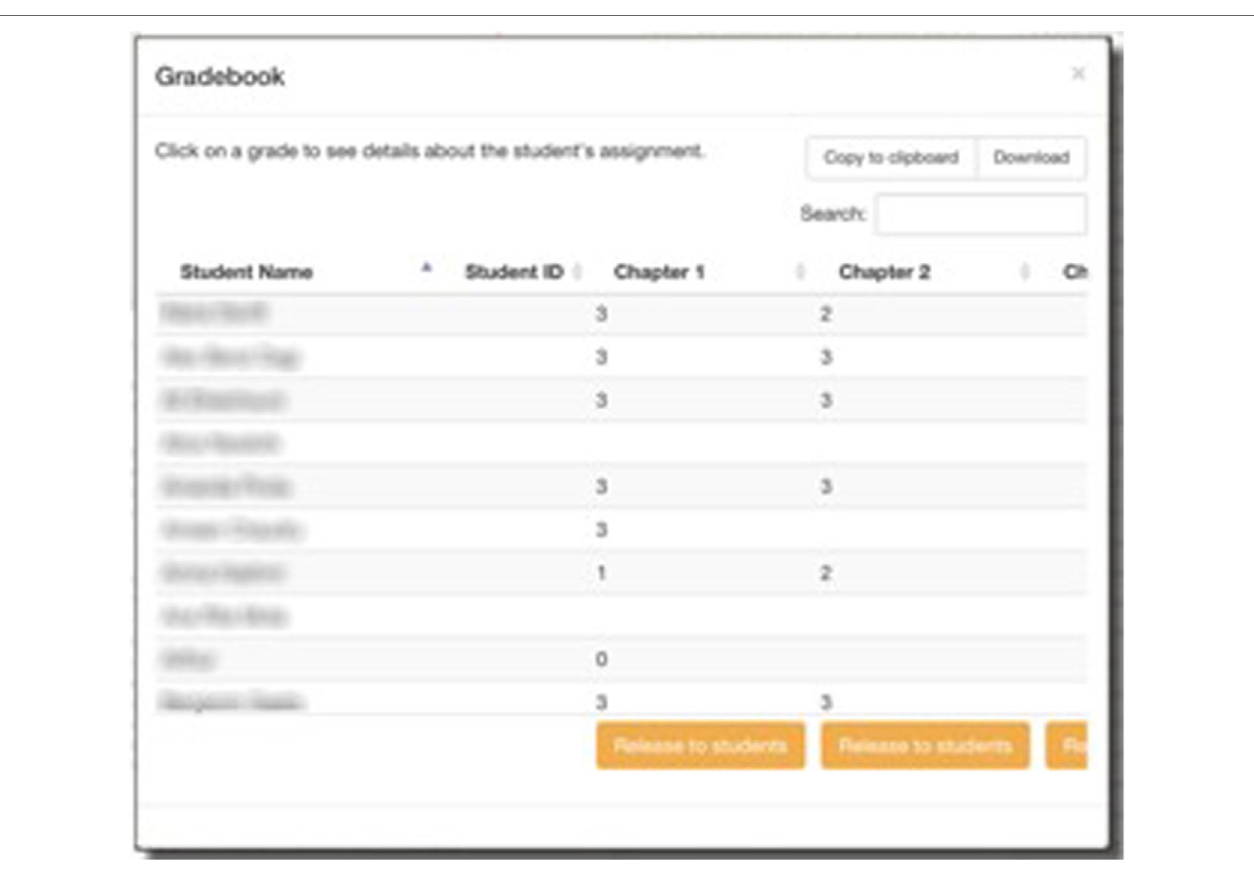
FigUre 7 | Gradebook in Perusall.